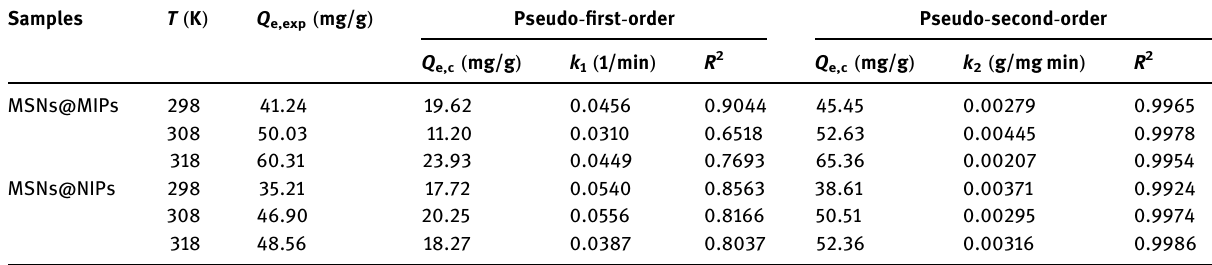
Table 2: Kinetic constants of the pseudo - fi rst - order and pseudo - second - order kinetic models